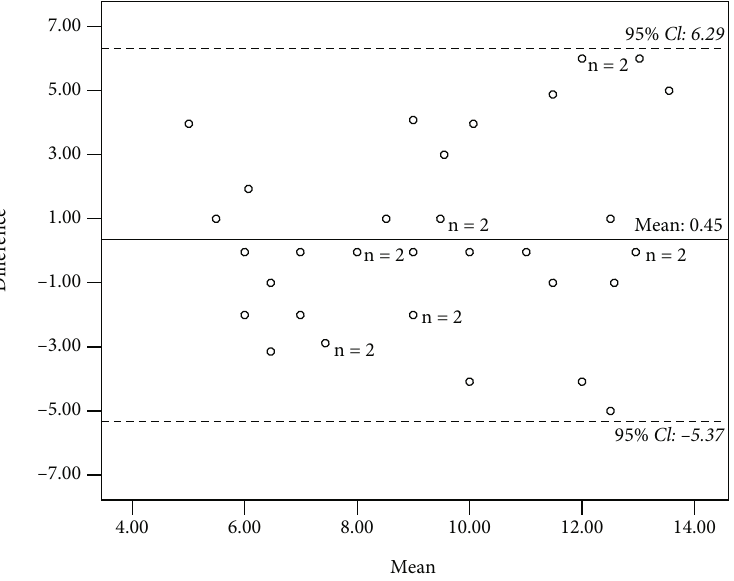
Figure 5: Bland-Altman plot for test-retest reliability